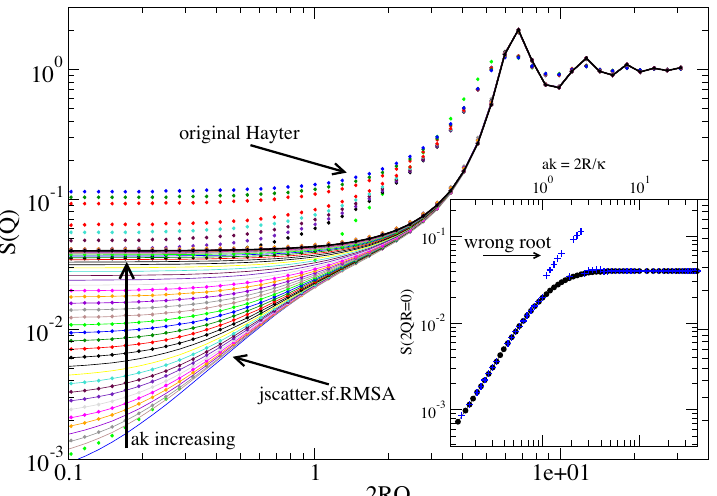
Fig 6. Comparison of the original algorithm of Hayter (dots) with the improved algorithm selecting the best solution of all 4 roots in Fw(w i ) (lines) for a contact potential Γ = 3 kT, volume fraction F = 0.4 and dimensionless screening ak = 0.1–58. We observe the second set of solutions representing the wrong solutions (only dots) and some solutions missing in the original solution (only line). The inset shows the respective S(Q = 0) values for the improved solution (black) compared to the original solution (blue). Here some points are missing as no solution was returned others show the wrong